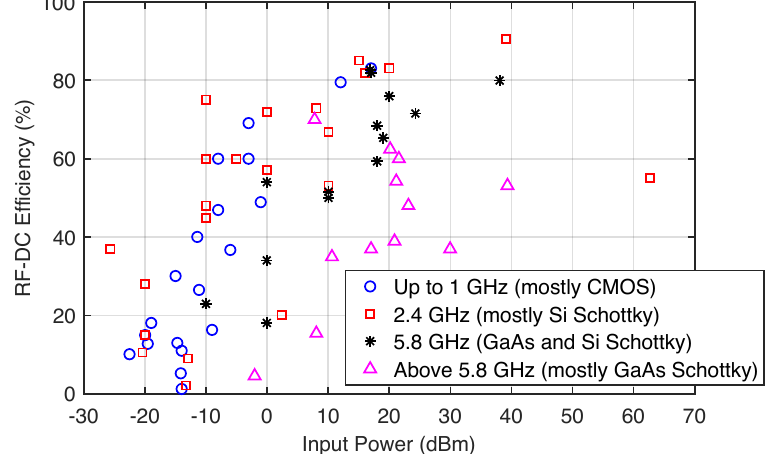
Figure 7. State of the art in RF-DC converters, with different topologies, from 450MHz to 94GHz. Adapted from